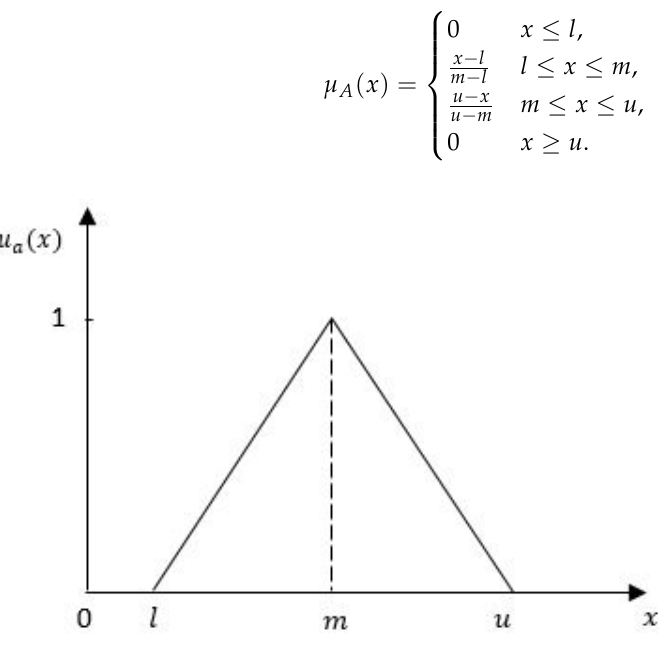
Figure 1. Triangular Fuzzy